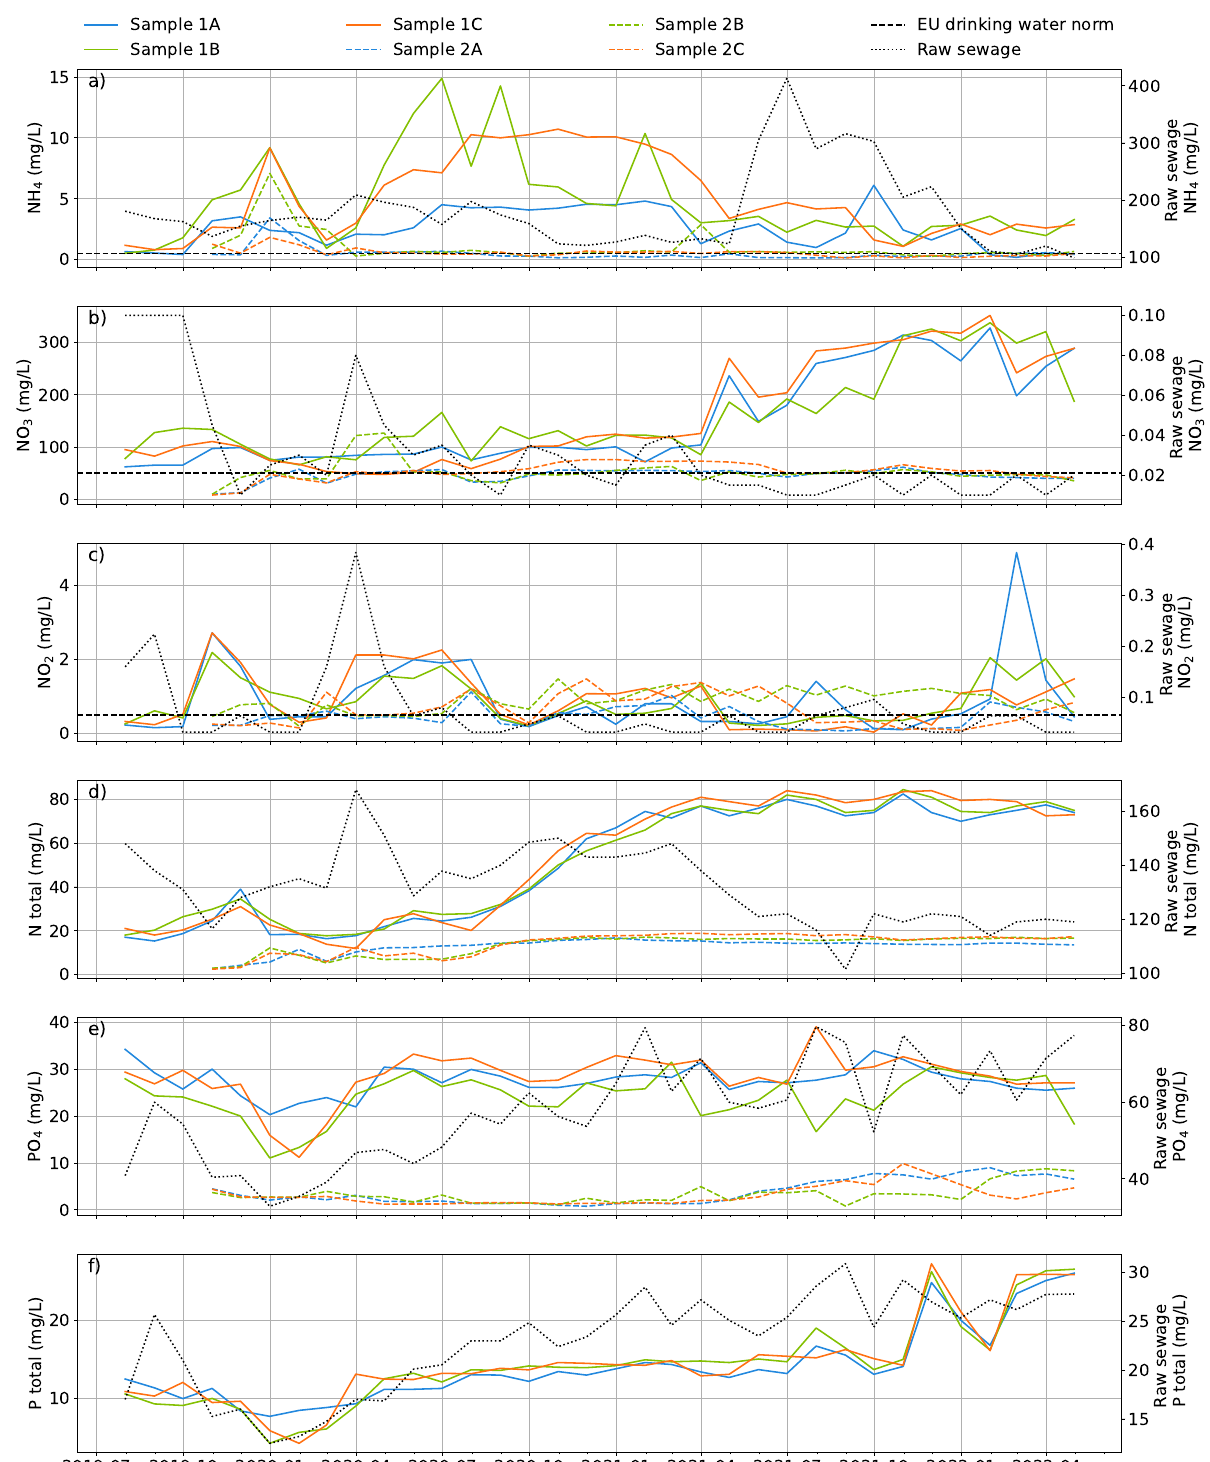
Figure 3. Concentration of biogenic substances in the treated sewage (sample 1) and in the renewed water (sample 2). The letters A, B and C refer to three different hydraulic loads: 70, 100 and 130 L/m 2 , respectively. ( a ) Ammonium (NH 4 ), ( b ) nitrate (NO 3 ), ( c ) nitrite (NO 2 ), ( d ) total nitrogen, ( e ) phosphate (PO 4 ) and ( f ) total phosphorus. The drinking water quality recommendation is taken from the European Council Directive